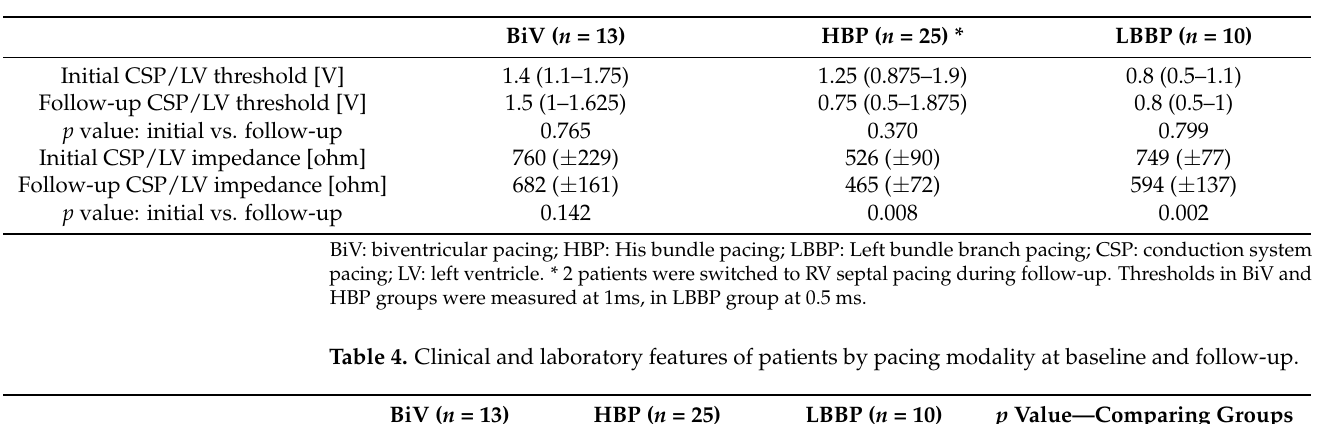
Table 3. Pacing parameters by pacing modality at baseline and follow-up.